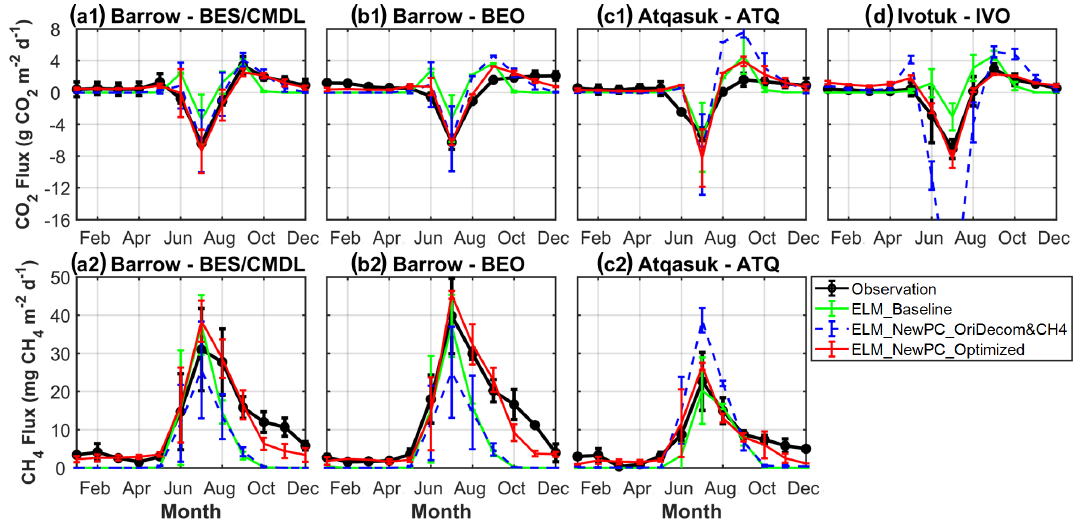
Figure 7. Comparison of multi-year (2013–2017) averaged monthly mean net CO 2 flux ( a1, b1, c1, d ) and CH 4 emissions (a2, b2, c2) from simulations and measurements at the study sites. The error bars represent standard deviation of monthly mean.